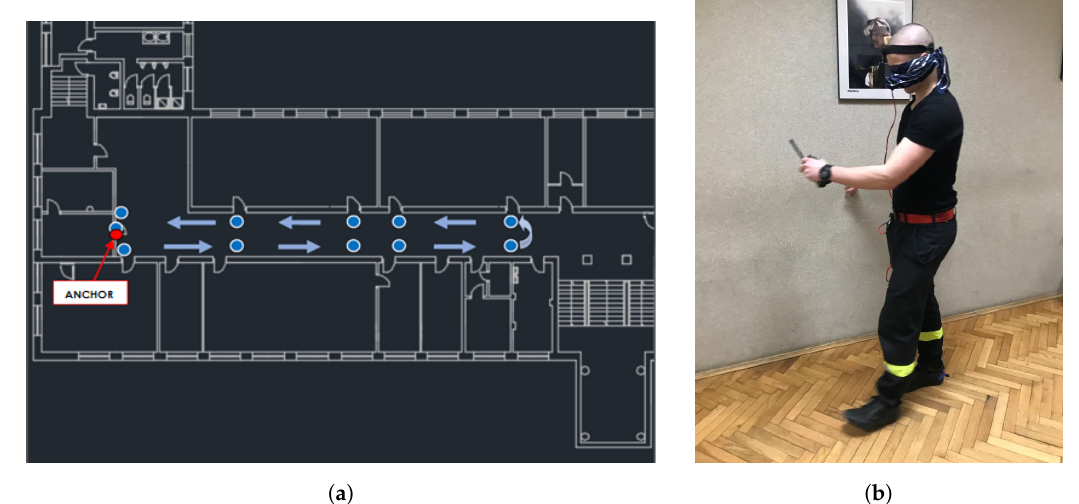
Figure 9. Test II. ( a ) Marked stop points for the path in Test II; ( b ) The movement along the wall during Test II.